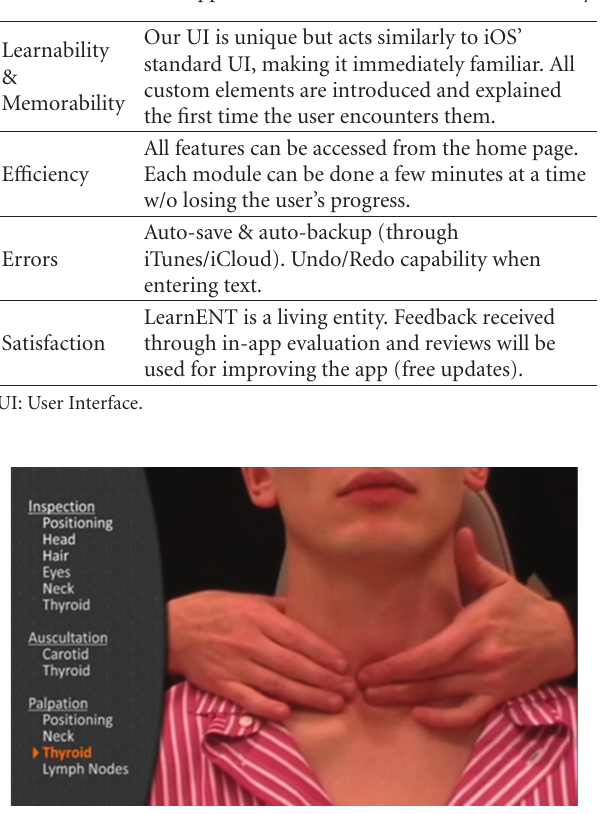
Table 2: LearnENT’s approach to Nielsen’s attributes of learnability.